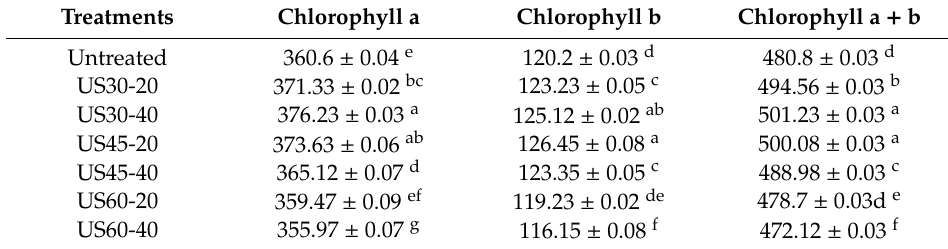
Table 4. Impact of TU treatment on carotenoids and chlorophyll